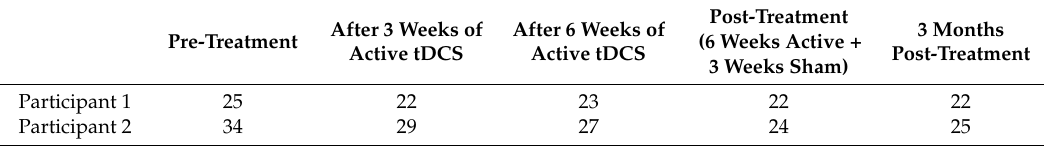
Table 2. Premonitory Urge for Tics Scale (PUTS)